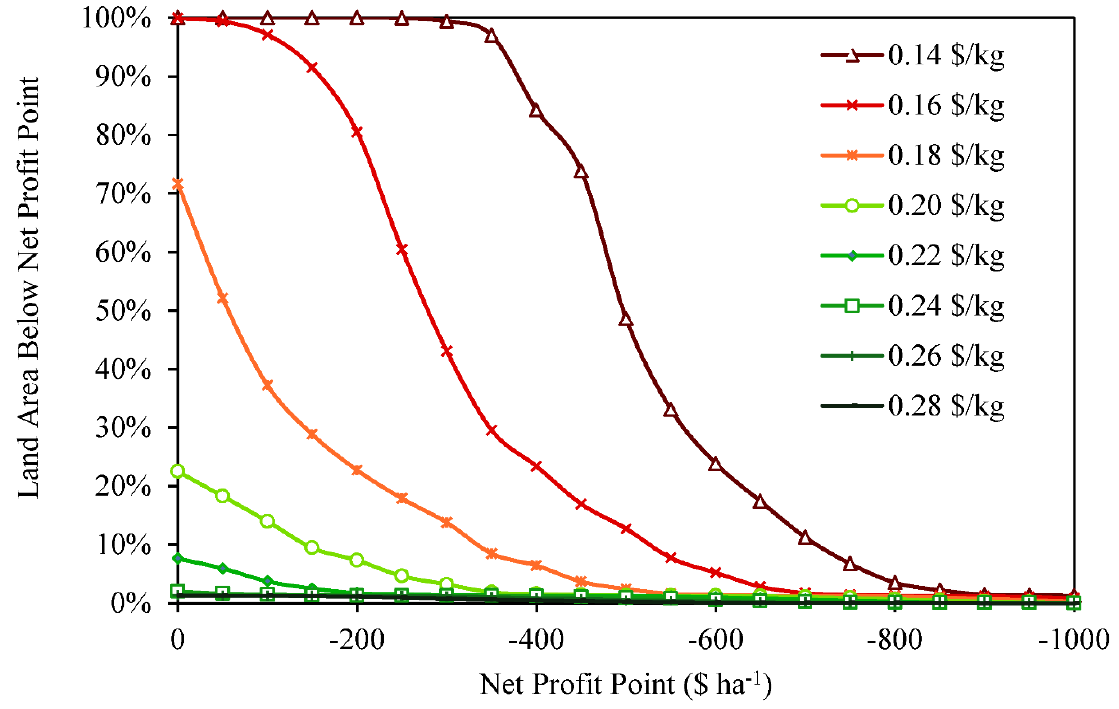
Figure 4. Area within Hardin County, Iowa operating at or below a range of six year average net losses based on varied corn grain